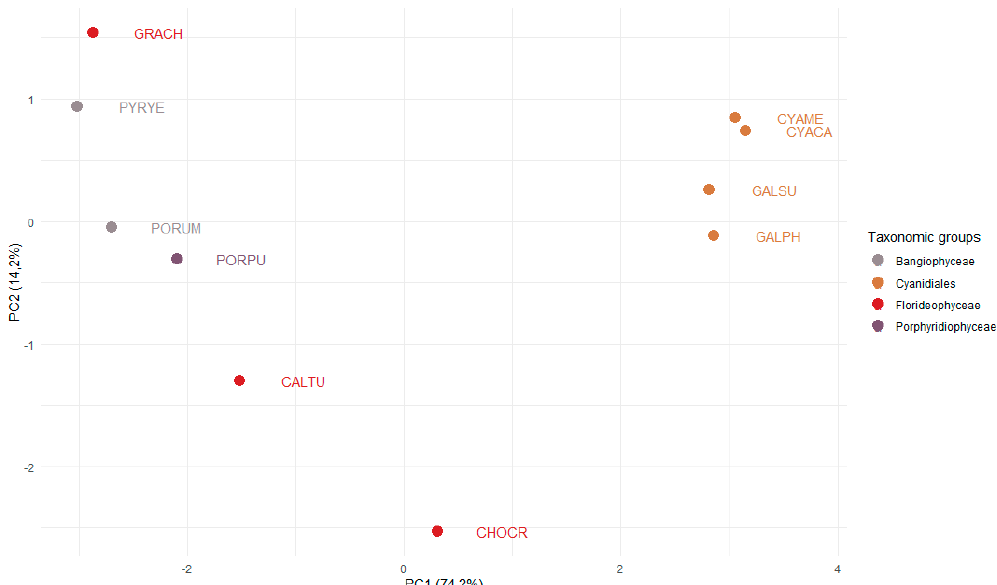
Figure 3. PCA analysis of the number of TAP families in red algae. Data for 62 TAP families from ten red algae of the taxonomic groups Cyanidiales, Porphyridiophyceae, Florideophyceae, and Bangiophyceae were used to perform a principal component analysis. The x -axis shows the first principal component, explaining 74.2% of the variance. The y -axis shows the second component (14.2% of variance). The data points are color-coded according to the corresponding taxonomic group. The names of the species are abbreviated using a five-letter code. Cyanidiales (unicellular): CYAME = Cyanidioschyzon merolae , CYACA = Cyanidium caldarium , GALSU = Galdieria sulphuraria , GALPH = Galdieria phlegrea . Bangiophyceae: PYRYE = Pyropia yezoensis , PORUM = Porphyra umbilicalis . Porphyridiophyceae: PORPU = Porphyridium purpureum . Florideophyceae (multicellular): GRACH = Gracilariopsis chorda , CALTU = Calliarthron tuberculosum , CHOCR = Chondrus crispus